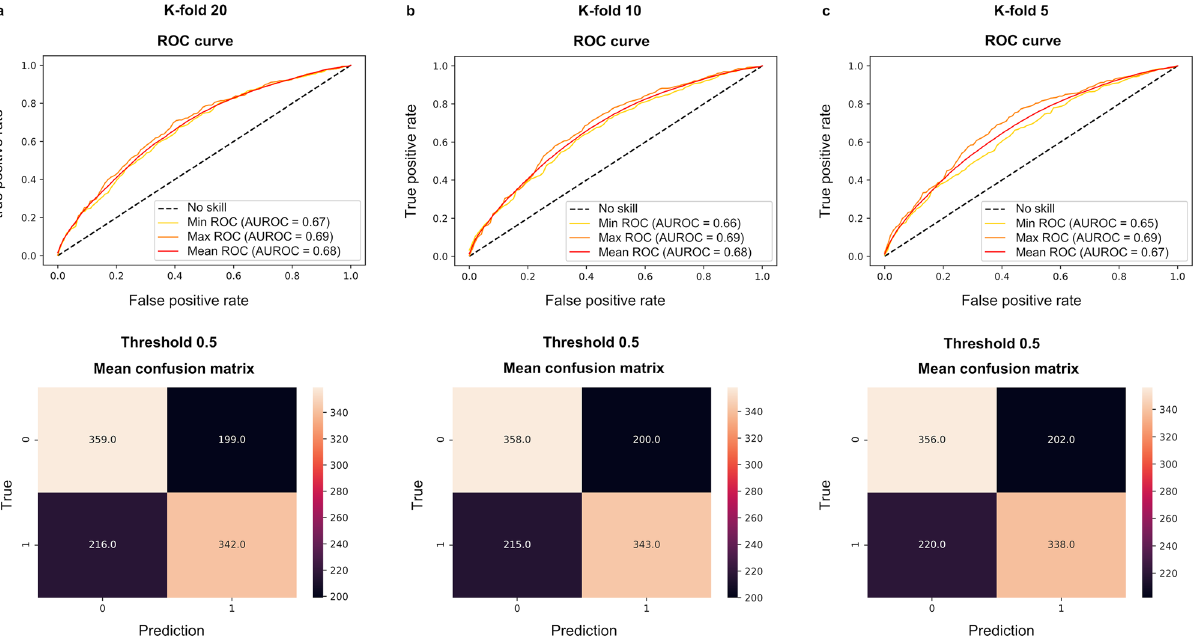
Figure 5. Averaged ROC curves and confusion matrices from the PLS-DA analysis. Results from ( a ) k-fold 20, ( b ) k-fold 10 and ( c ) k-fold 5 have been presented. The PLS-DA k-fold cross-validation predictive ability was repeated 100 times with k-folds 20, 10 and 5. Training was accomplished with ATR-FTIR data from the spectral region of 1800–900 cm −1